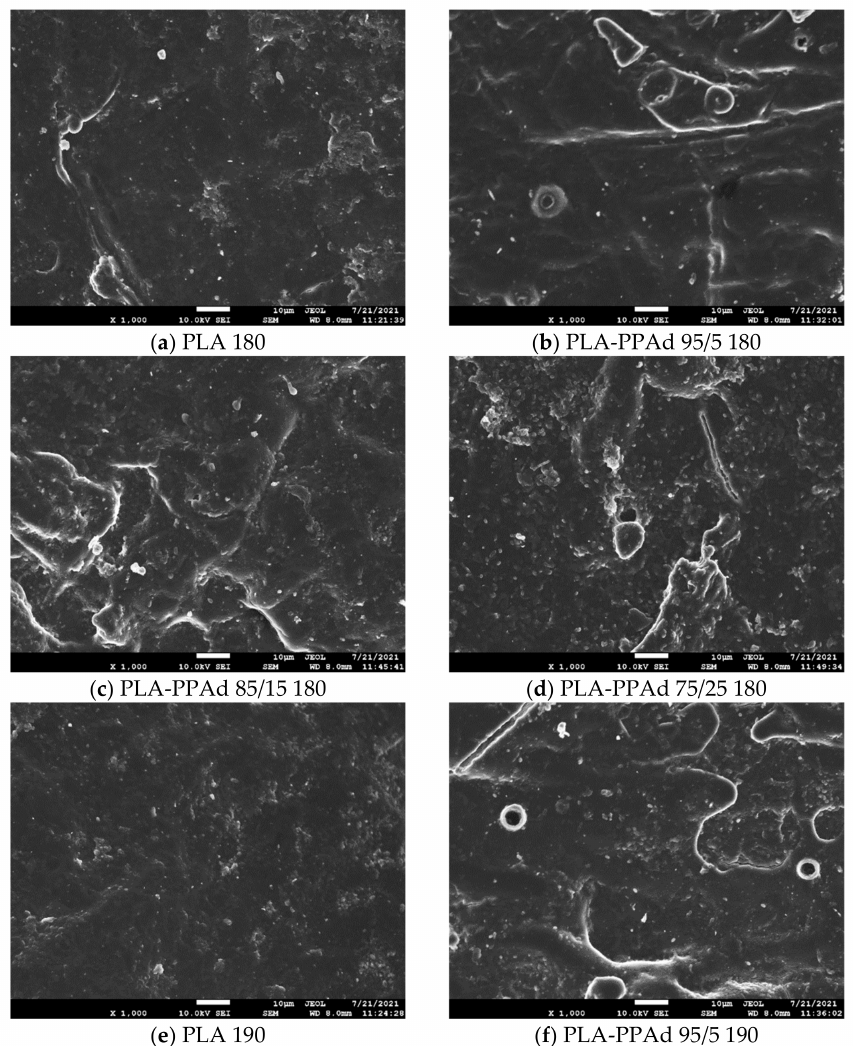
Figure 12. SEM micrographs of the surfaces of the samples after 30 days of enzymatic